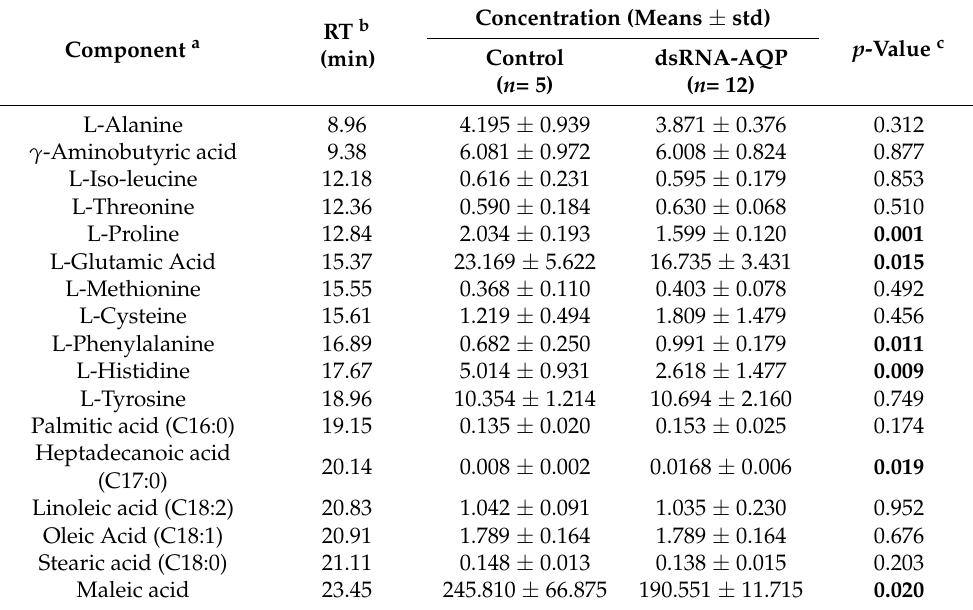
Table 3. Concentrations of different metabolic compounds (ng · insect − 1 ) detected in D. citri adults after derivatization with MCF using gas chromatography-mass spectrometry